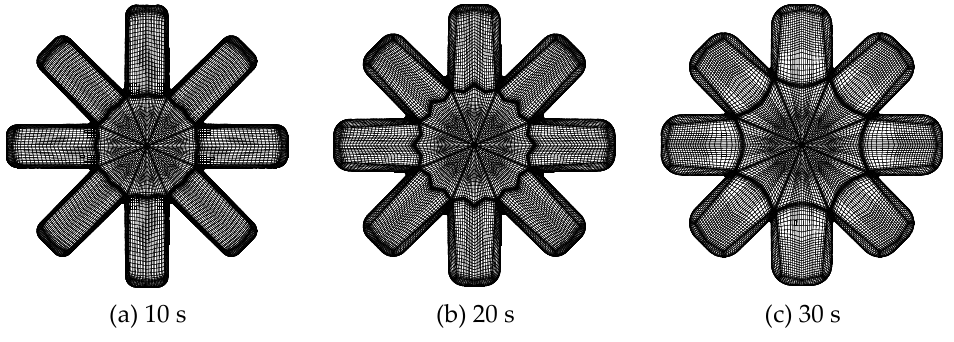
Figure 31. Cross sections of fuel grain at 10 s, 20 s, and 30 s.